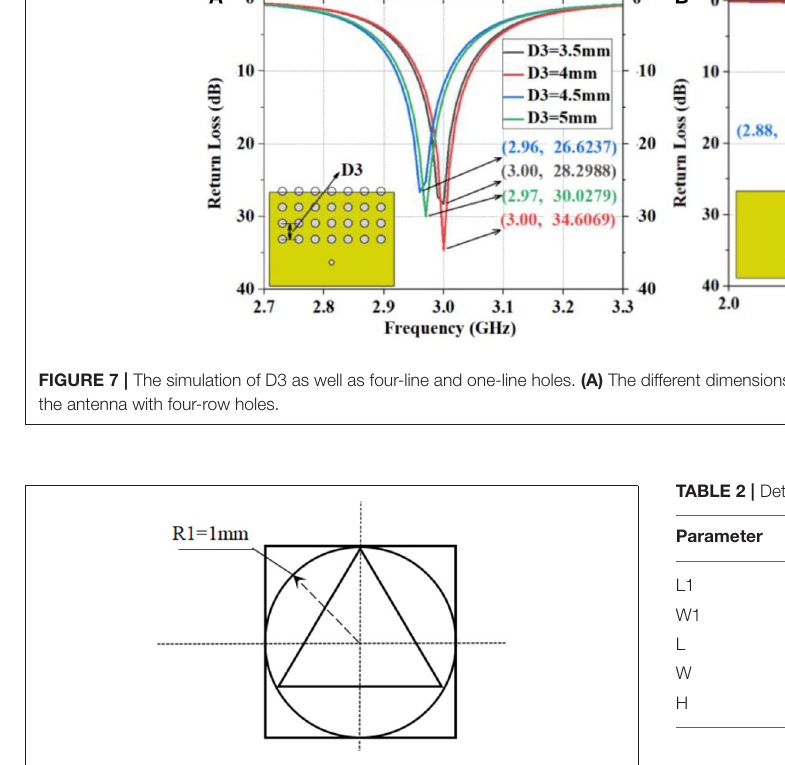
FIGURE 8 | The planar structure of the through hole, the square hole, and the triangular hole.